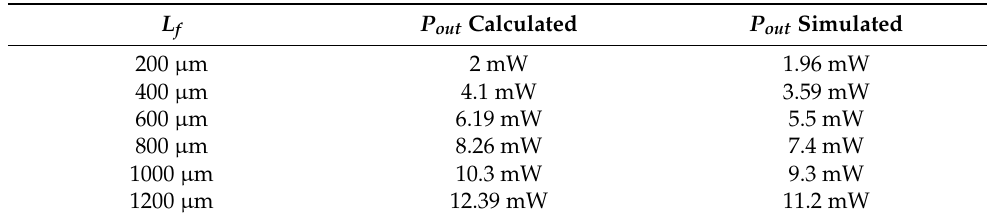
Table 3. P out at different L f .